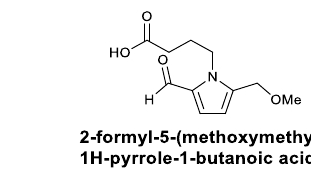
Figure 14. Structures of pyrrole alkaloids.